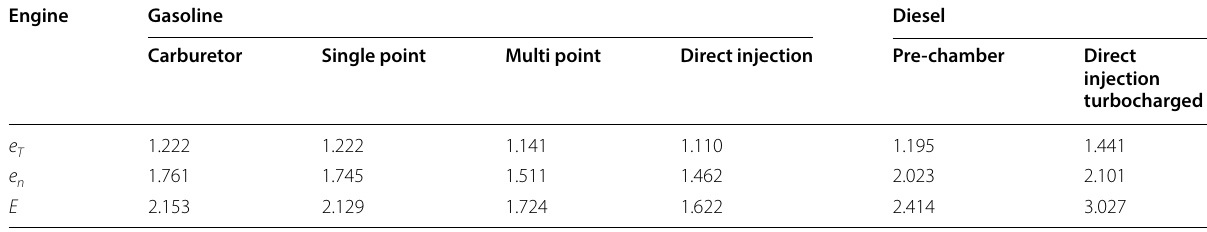
Table 3 Flexibility of combustion engines [4] Engine